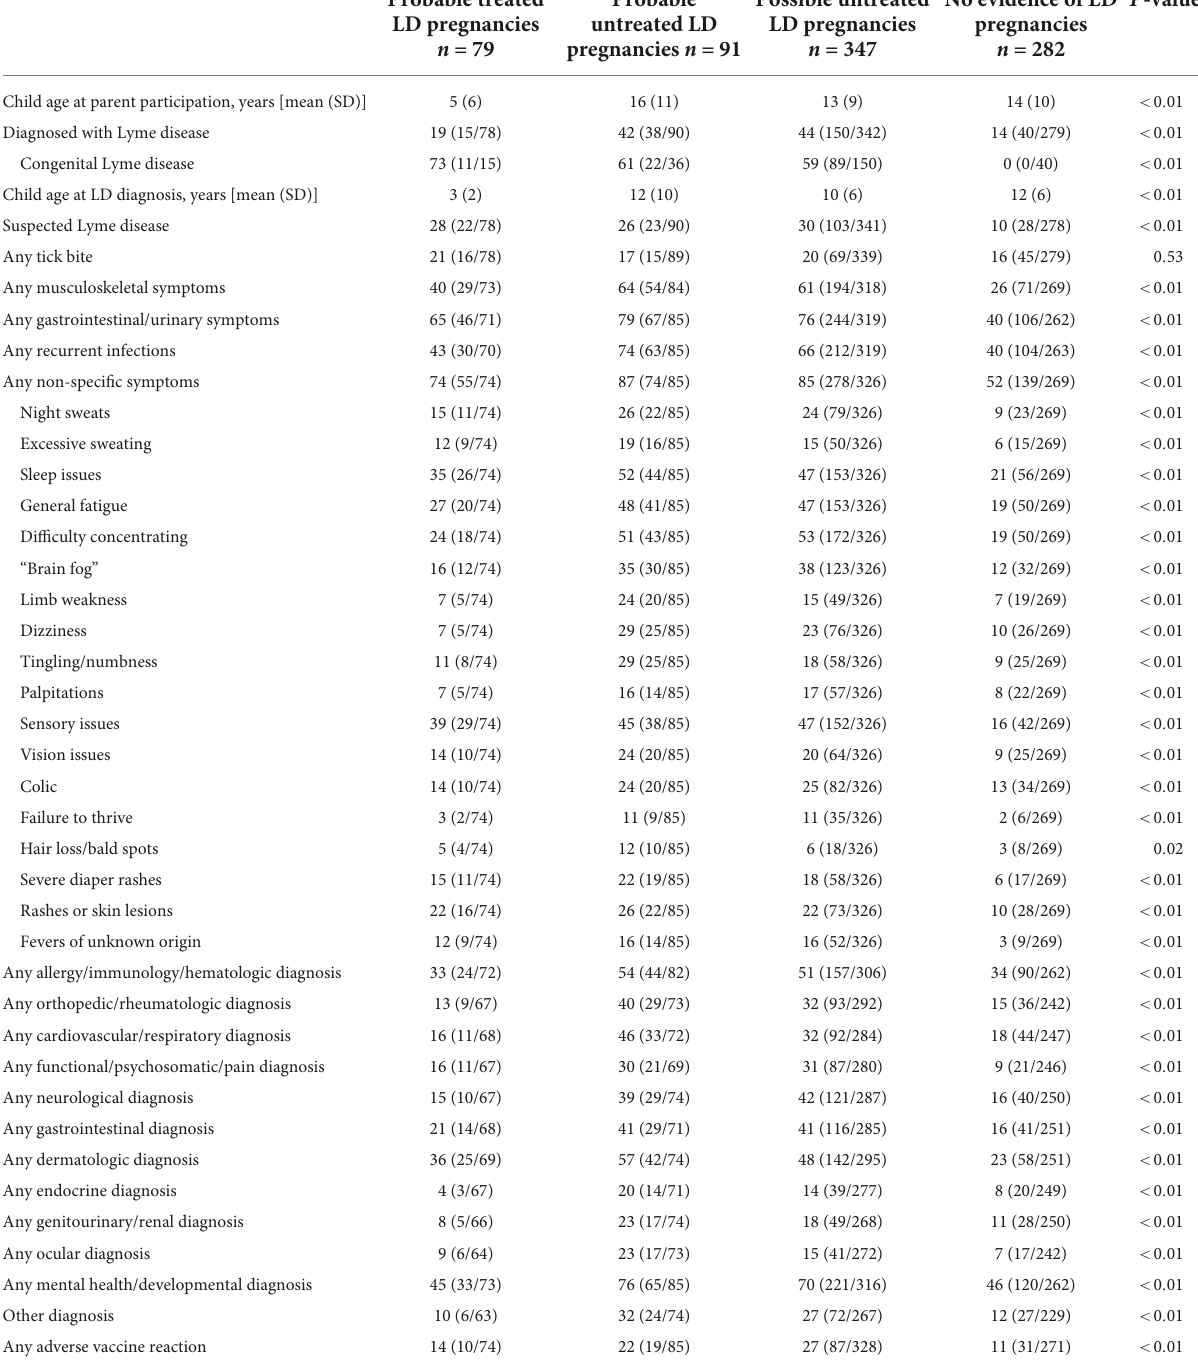
TABLE 6 Child outcomes by participant/parent LD